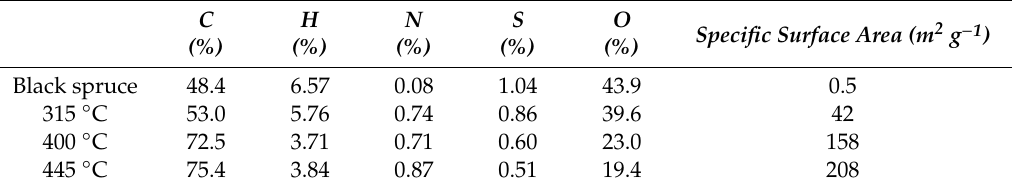
Table 2. Physicochemical properties of wood residues and biochar.